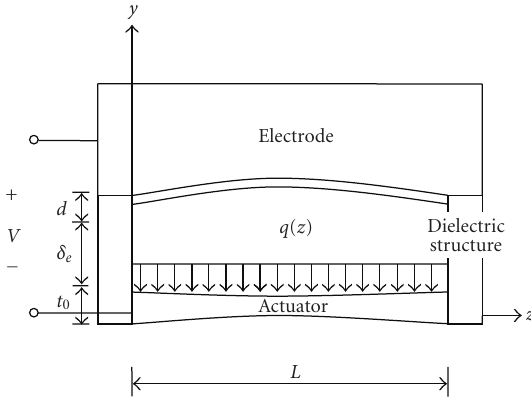
Figure 1: Schematic view of an electrostatic fixed-fixed